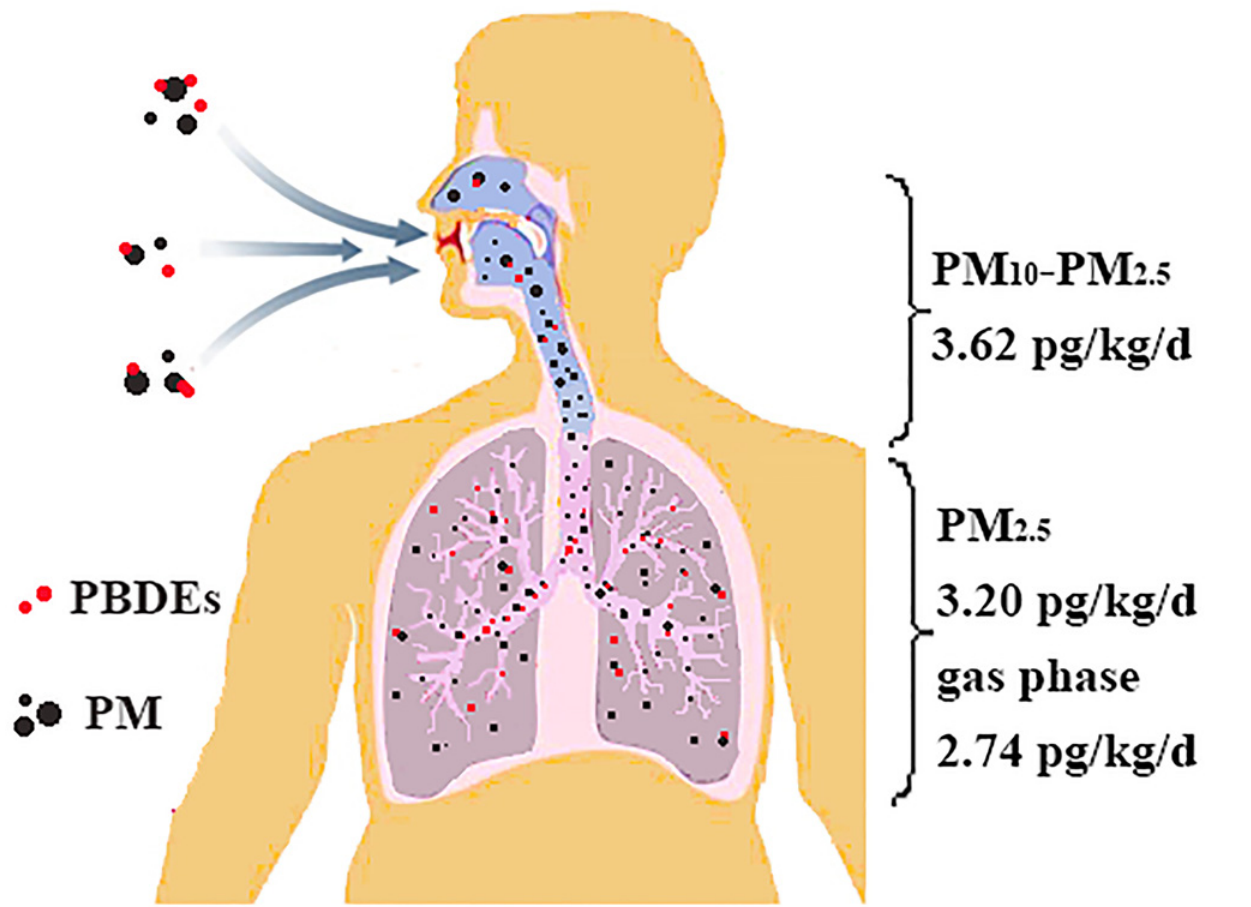
Fig 2. Daily exposure to PBDEs via inhalation of PM 2.5 , PM 10 , TSP and gas